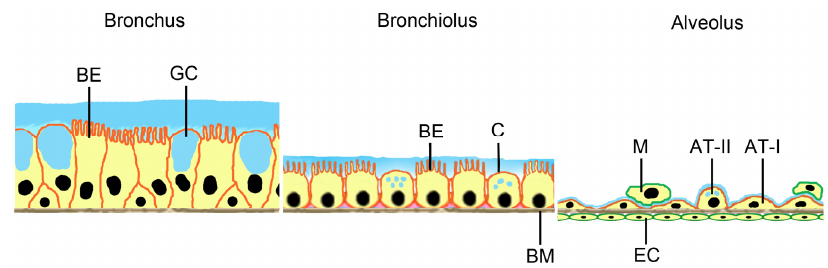
Figure 1. Barriers for particle uptake by the respiratory system. Surfaces of larger (conducting) airways are mainly covered by bronchial epithelial cells with cilia (BE) and mucus (blue) producing goblet cells (GC). In bronchioli, bronchial epithelial cells and mucus producing cells (Clara cells, C) are found. All epithelial cells reside on a basement membrane (BM). The air-blood barrier at the alveolus consists of alveolar epithelial cells type I (AT-I) and surfactant-producing AT-II cells. Alveolar macrophages (M) migrate on top of the alveolar epithelial cell layer. On the other side of the basement membrane endothelial cells (EC) of capillaries are